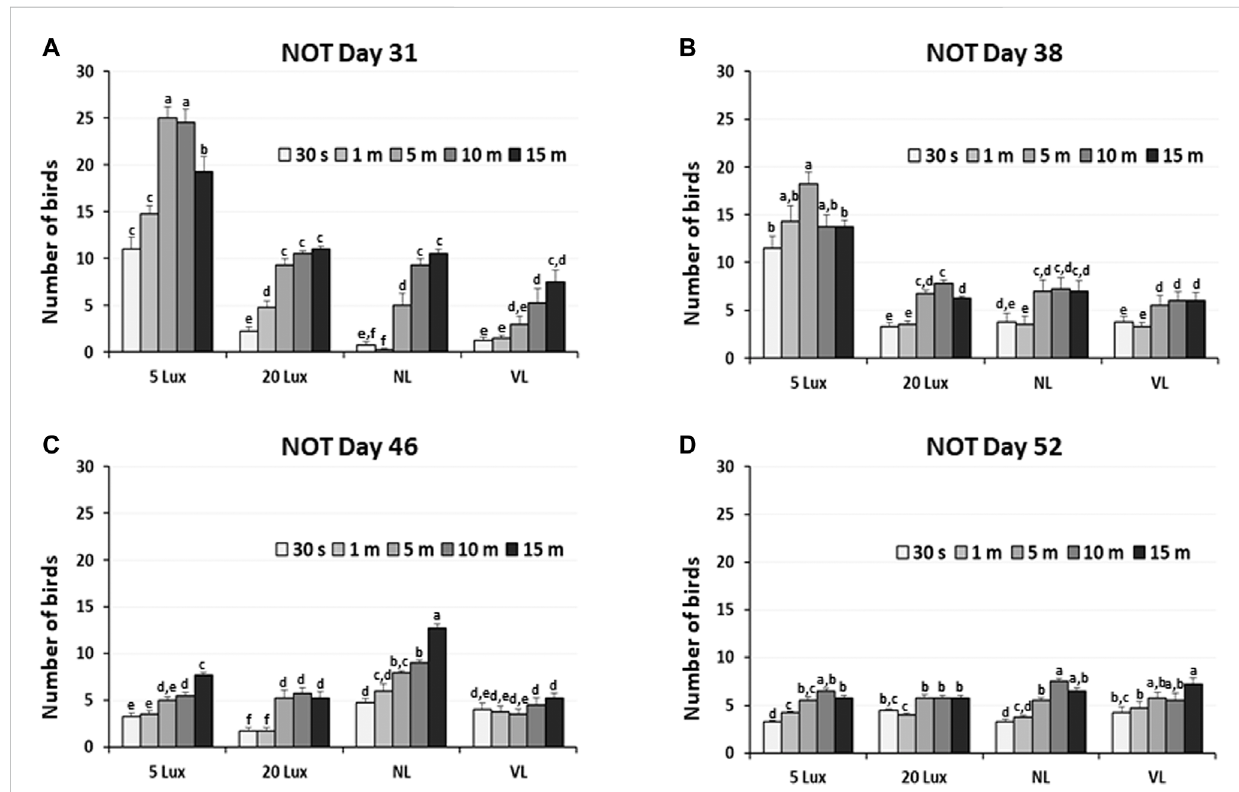
FIGURE 3 Novel object test in four different lighting program houses (5 lx, 20 lx, NL, and VL) at different ages (A) age of day 31, (B) age of day 38, (C) age of day 46,and (D) ageofday52.Numbersofbirdsapproachingthenovelobjectwereobtained inthesequentialtimepoints(30 sec,1,5,10,and15 min)ineach section of the houses, and data (mean ± SEM) were compared among treatments. Different lower-case letters above the bars denote signi fi cant differences ( p < 0.05) among groups, where a > b > c > d > e > f and a,b is not different from a or b.